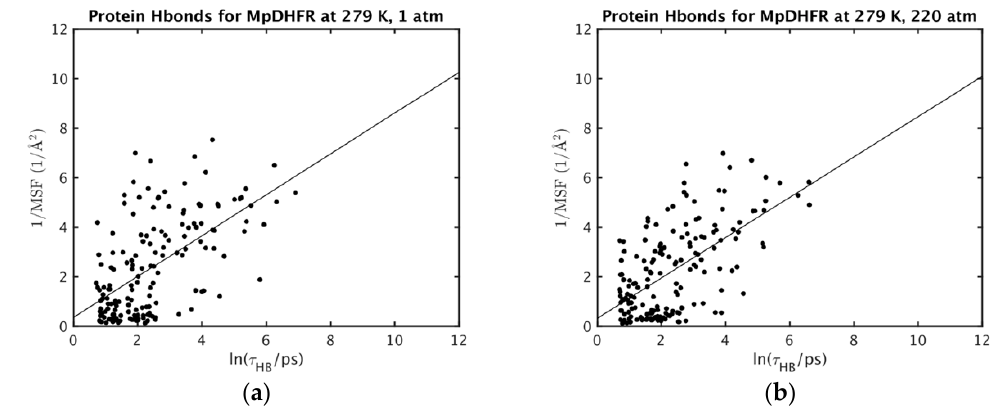
Figure 2. Correlation of inverse atomic fluctuations of hydrogen bond acceptors with the associated hydrogen bond lifetimes longer than 2 ps for MpDHFR at 279 K and ( a ) 1 or ( b ) 220 bar.